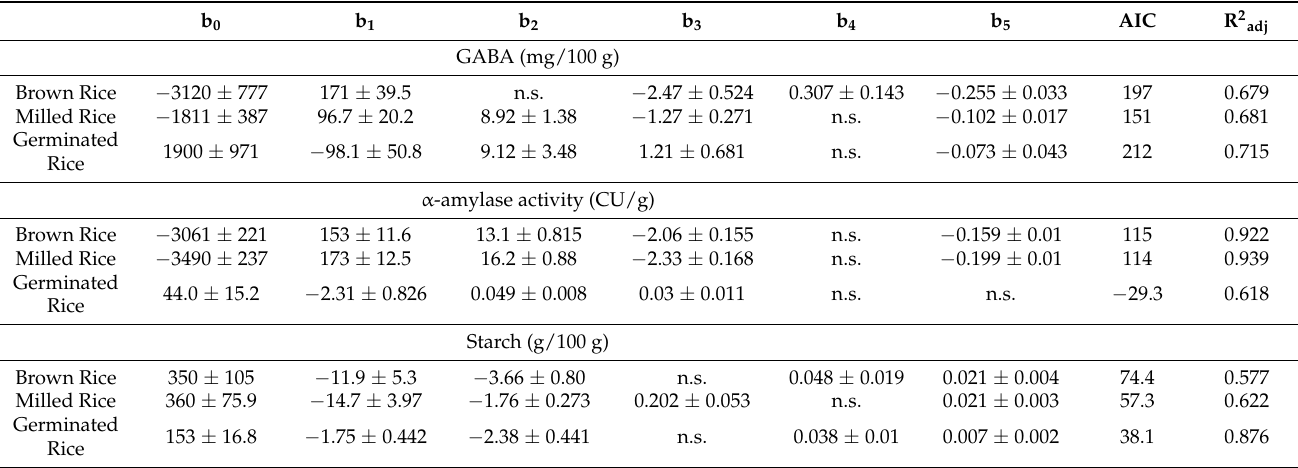
Table 2. Significant stepwise regression coefficients ( ± Std Error) ( p < 0.05) and R 2 adj , from the fitting of Equation (1) to GABA concentration, α -amylase activity and starch content. Values for temperature ( x 1 ) were expressed in ◦ C and incubation time ( x 2 ) was expressed in hours. Non-significant values ( p > 0.05) are presented as